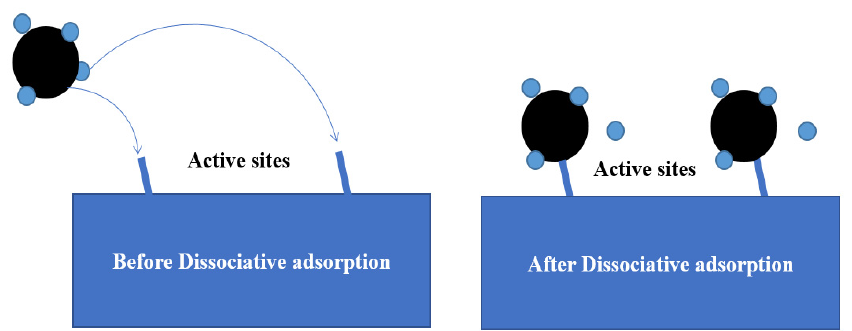
Figure 4. Schematic diagram of the methane dissociative adsorption mechanism model.